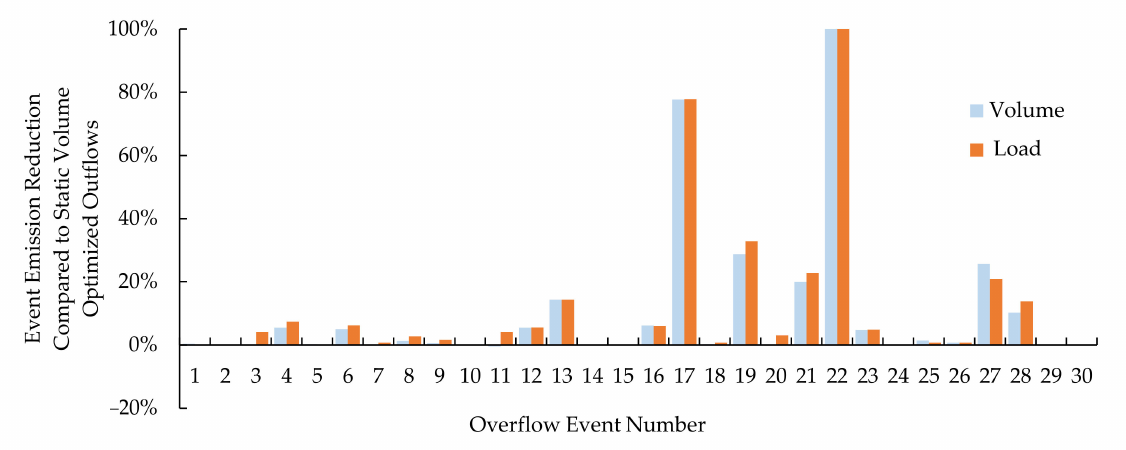
Figure 7. Combined sewer overflow volume reduction for the individual overflow events of the volume based real-time control compared to static optimized